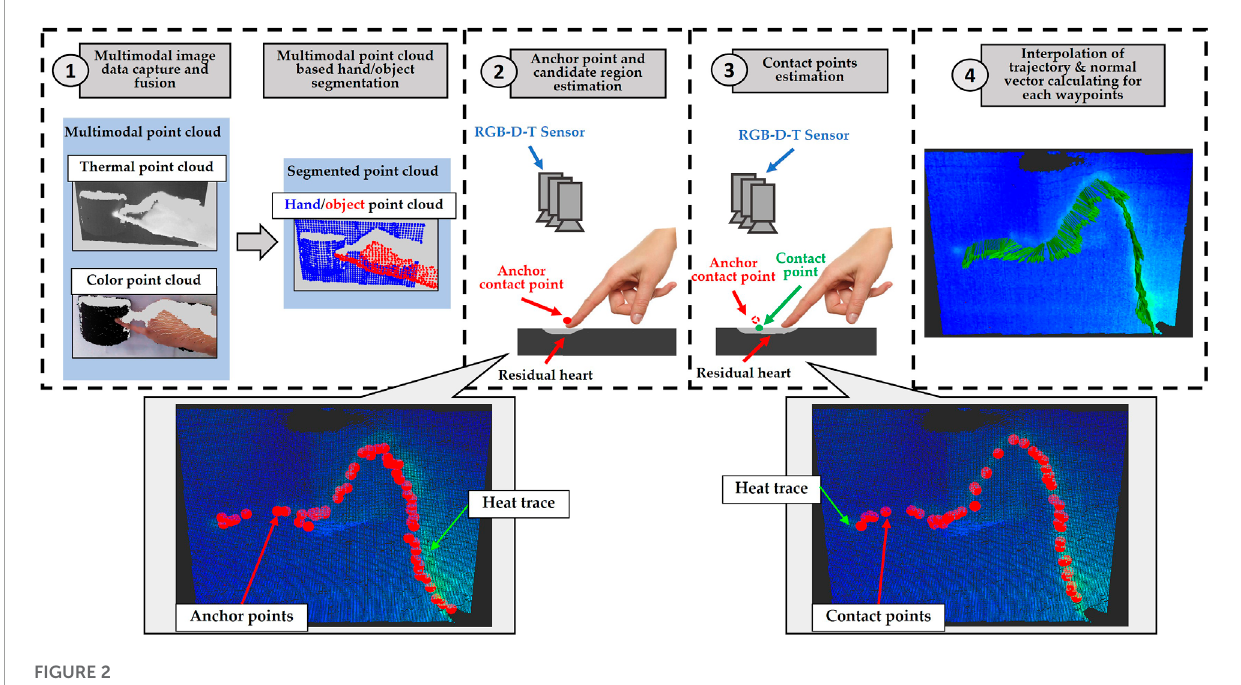
FIGURE 2 Method